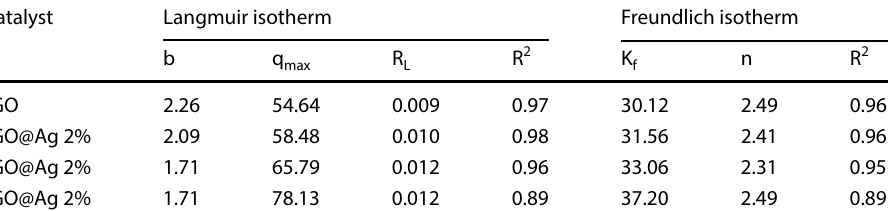
Table 2 Constants of Langmuir Catalyst Langmuir isotherm Freundlich and Freundlich models for the degradation of CR dye